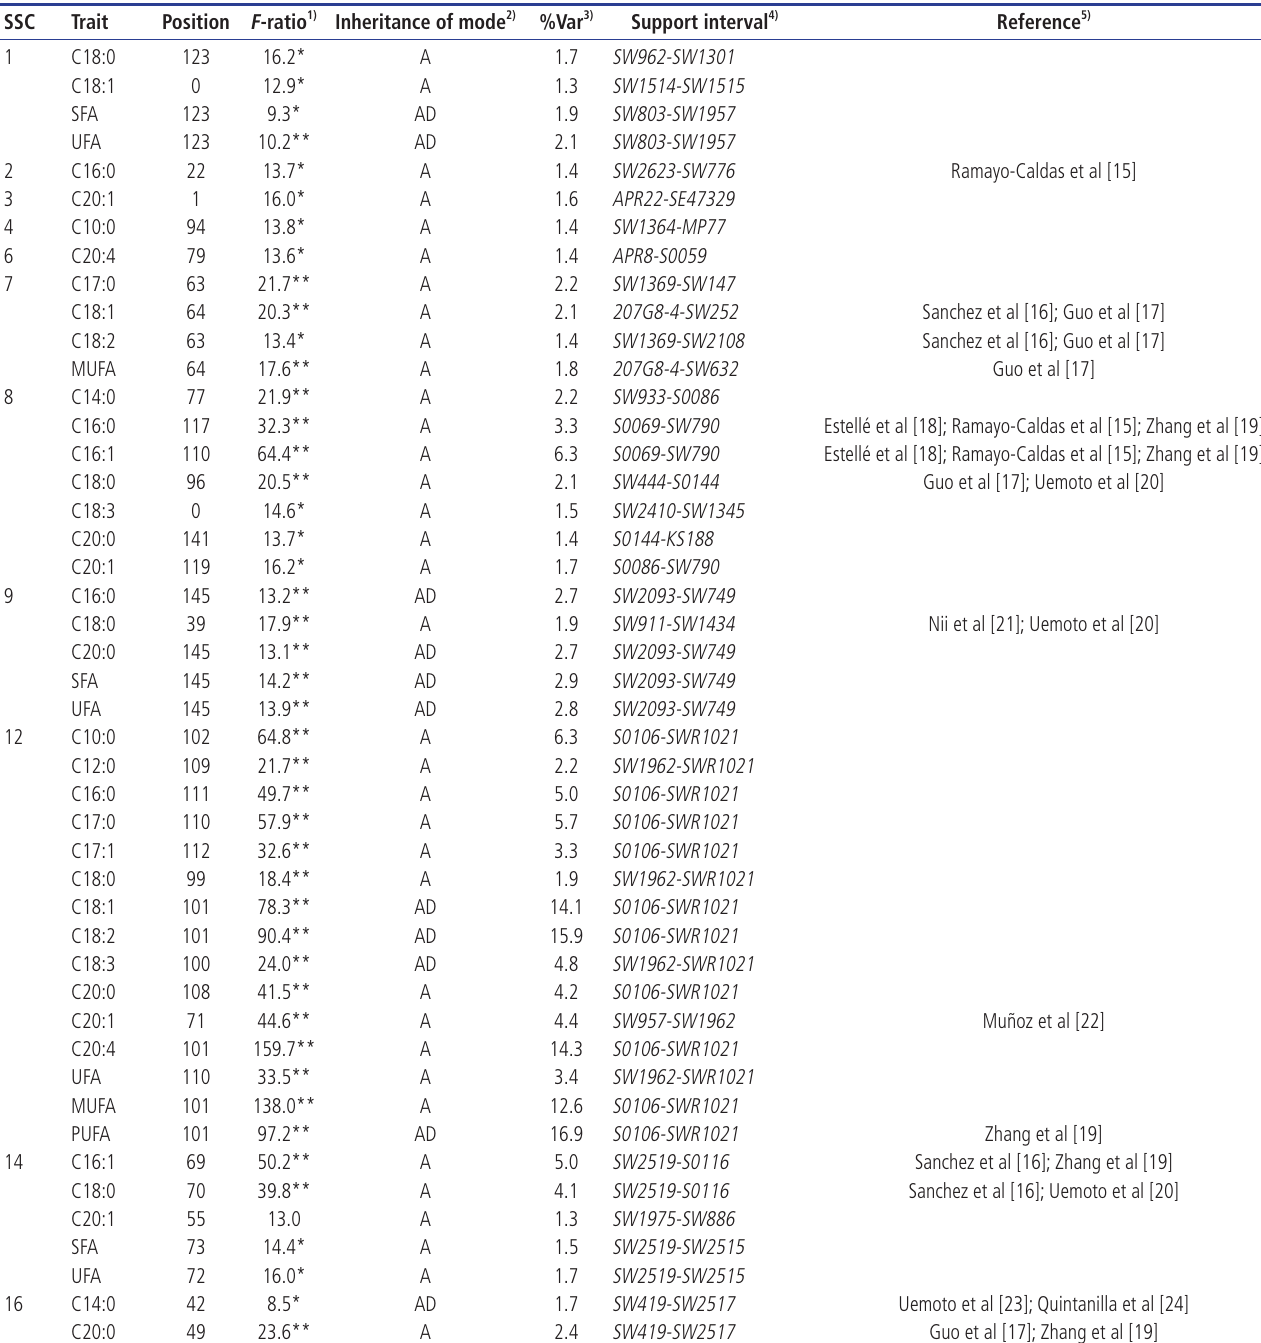
Table 1. Summary of identified significant QTLs for fatty acid